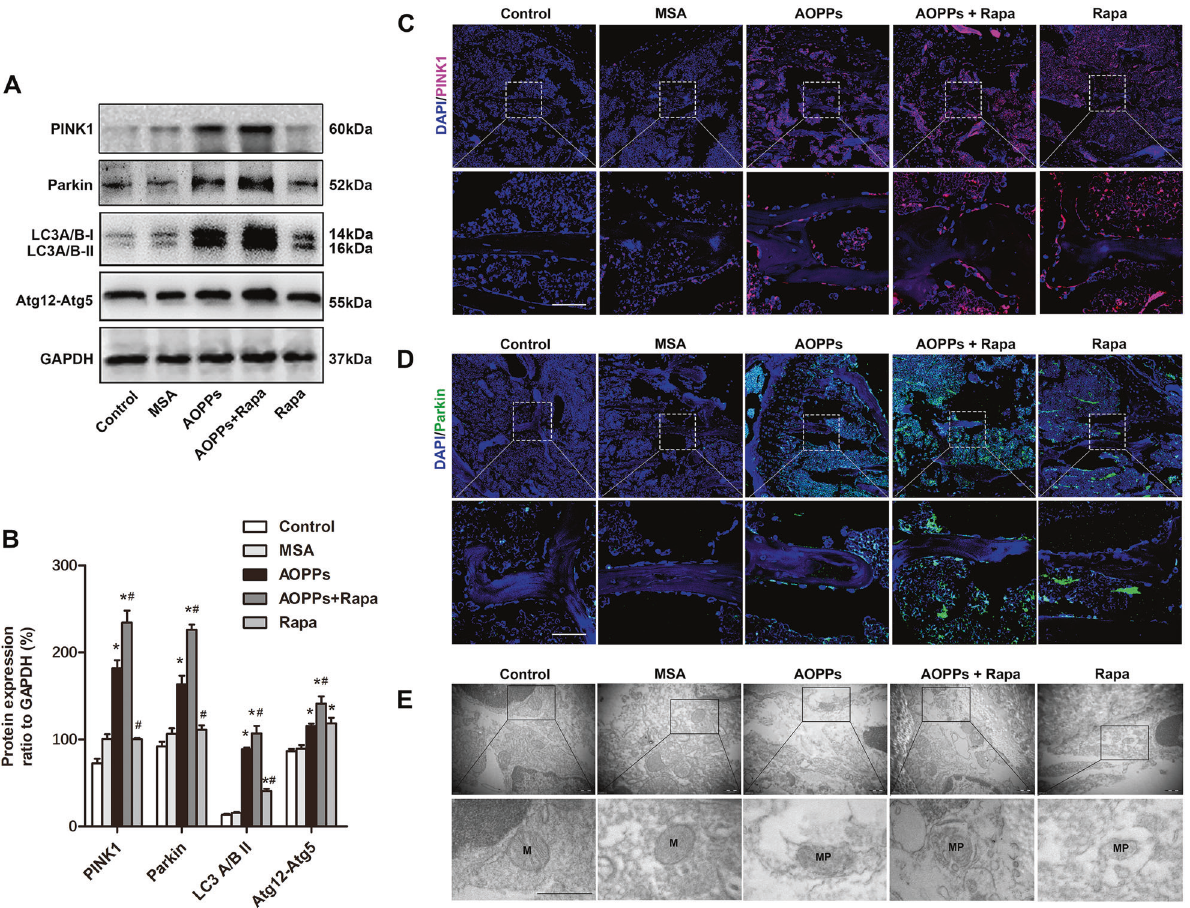
upregulated by additional rapamycin treatment. C , D Immuno fl uorescent staining results showed that both AOPPs and rapamycin could increase the expression of PINK1 and Parkin in osteoblasts, while the highest expression level was observed in the AOPPs + Rapamycin group (scale bar = 50 μ m). E Representative TEM images showing mitophagy (marked as MP) in the AOPPs, AOPPs + Rapamycin, and Rapamycin groups (scale bar = 500 nm). Data are presented as the mean ± SD, * P < 0.05 versus control, # P < 0.05 versus AOPPs, n =